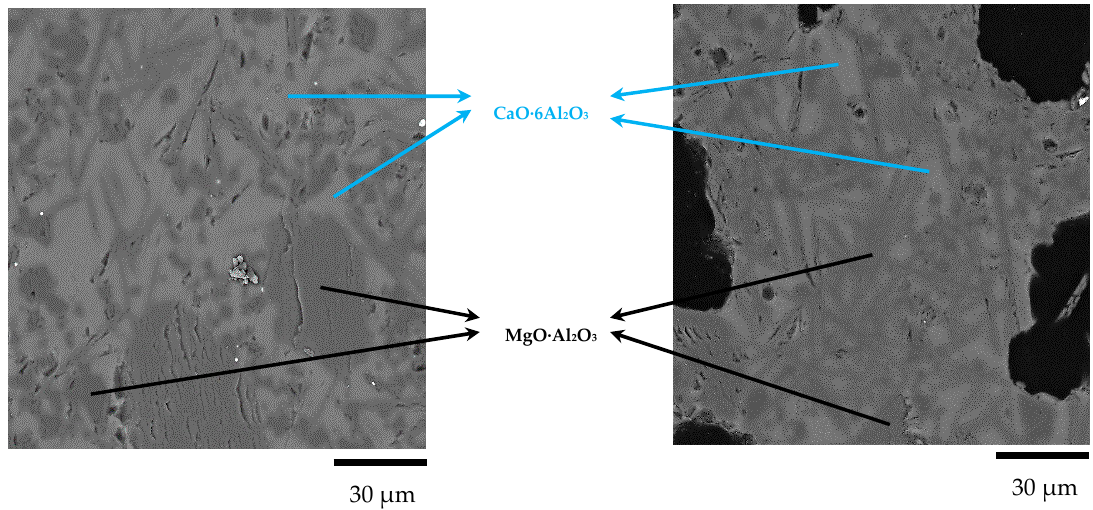
Figure 2. Scanning electron microscopy (SEM) images of the accretion.